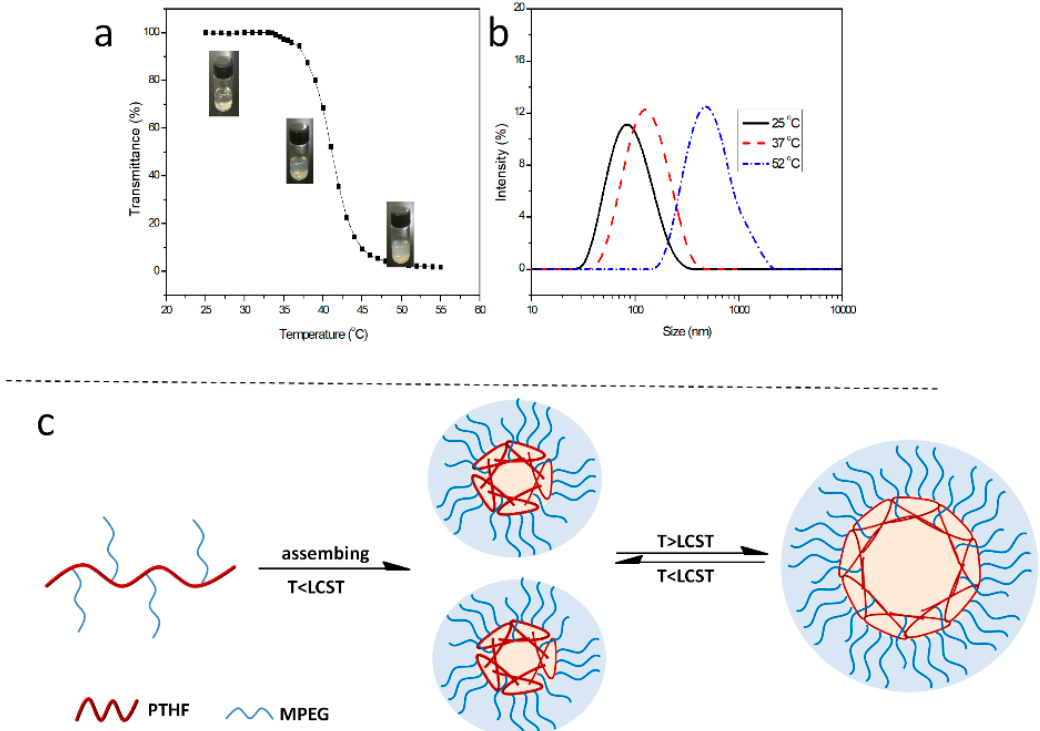
Figure 8. Transmittances of PTHF mPEG solution in different temperature ( a ). DLS traces of aggregates formed by the self-assembly PTHF mPEG in aqueous solution at temperature 25, 37 and 52 °C ( b ), [Polymer] = 0.5 mg mL − 1 . Schematic illustration of the mechanism for the temperature-triggered self-assembly behavior ( c ).